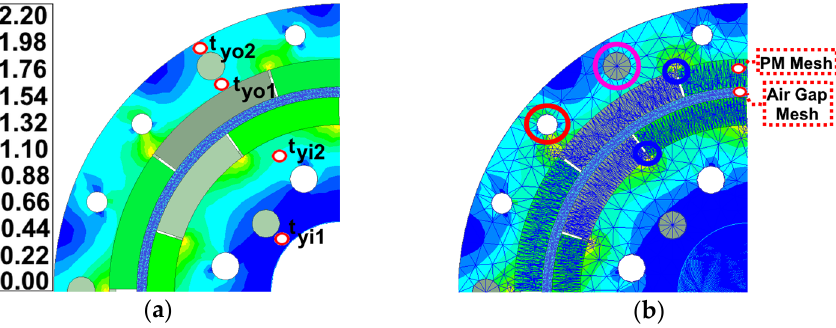
Figure 15. ( a ) Flux density distributions; ( b ) Mesh distributions.